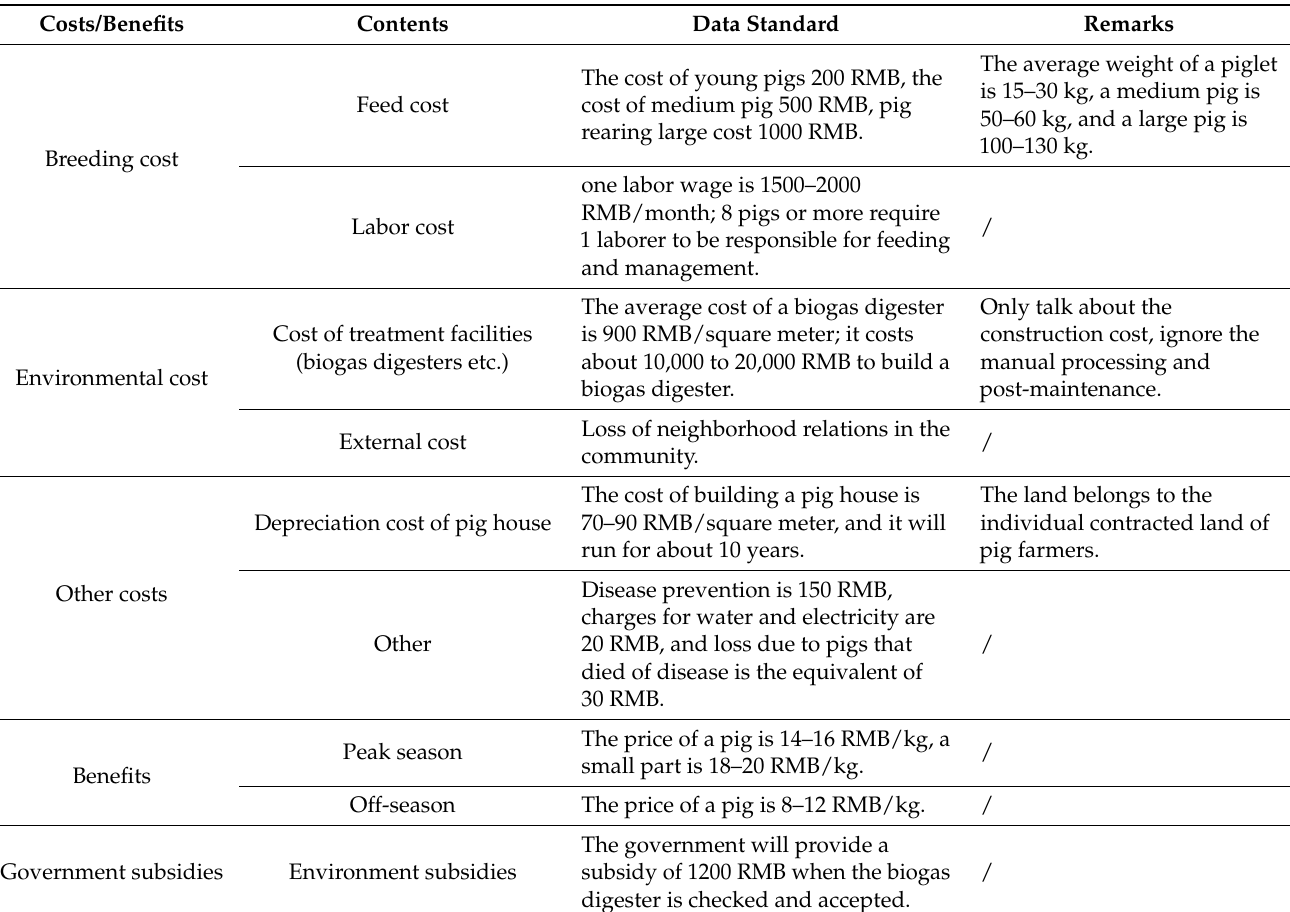
Table 3. Costs and benefits of pig